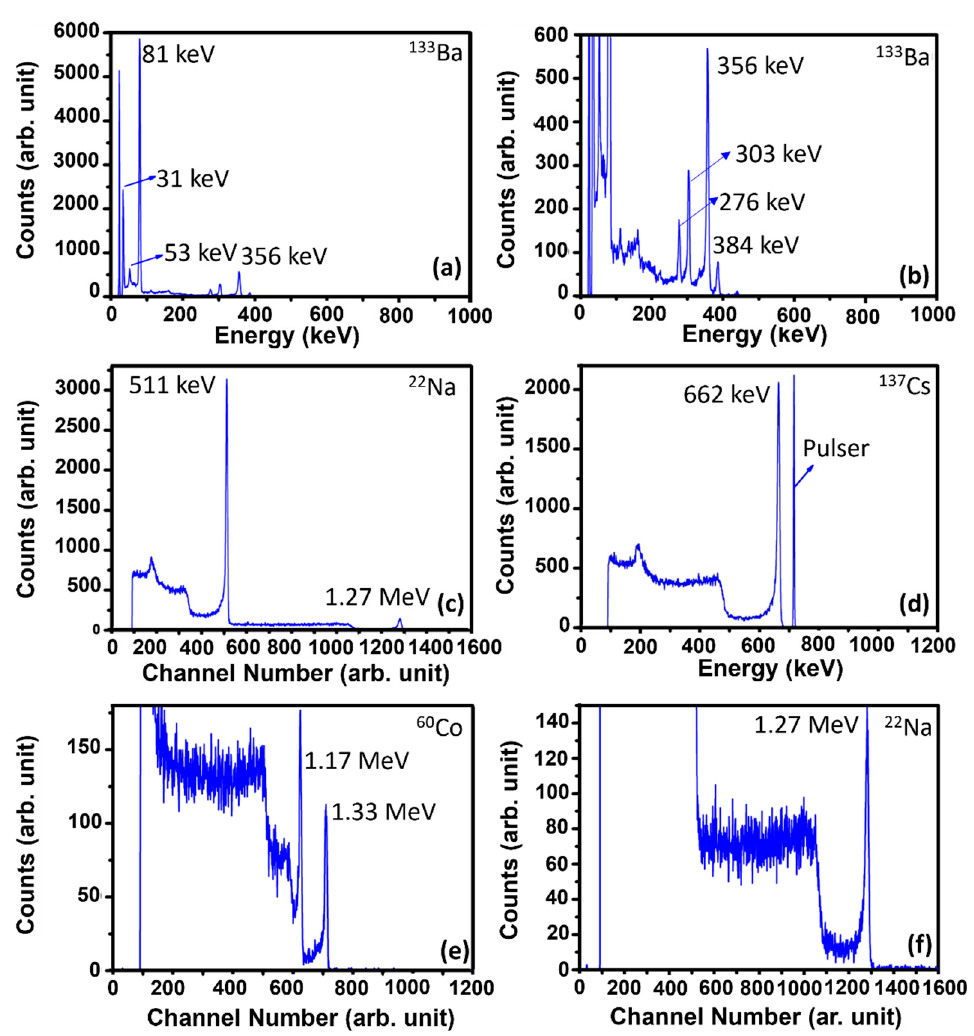
Figure 16. Gamma-ray PHS obtained from a THM grown Cd 0.9 Zn 0.1 Te 0.97 Se 0.02 Frisch collar detector with dimensions ~ 4.5 × 4.5 × 10.8 mm 3 with a 3-mm long Frisch grid for various gamma-ray ener- gies. The detector was biased at 3000 V for the above measurements (Adapted from ref. [17]. Copy- right 2019 Nature Research under Creative Commons Attribution 4.0 International License).